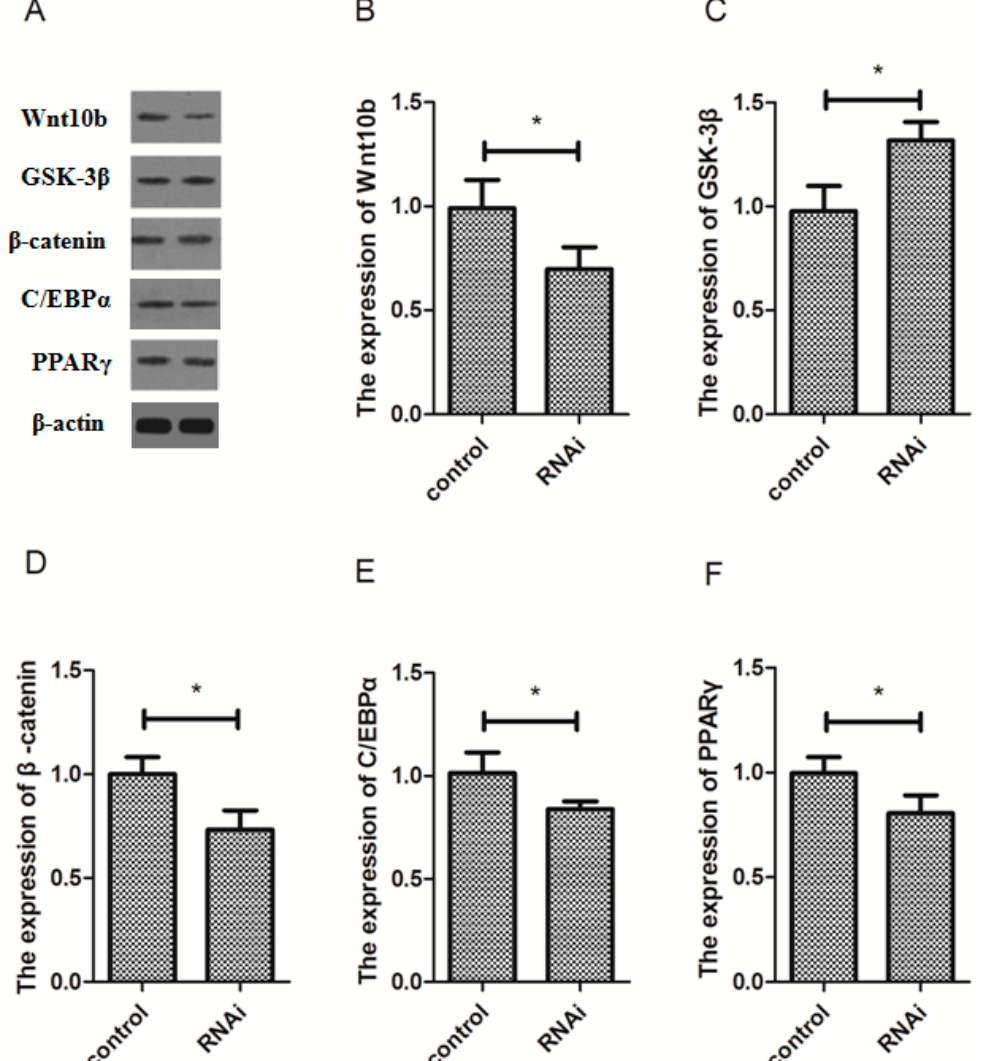
Figure 6. Effect of Wnt10b gene interference on the protein expression of Wnt10b, GSK-3 β , β -catenin, C/EBP α , and PPAR γ in the muscle of zebrafish. ( A ) The protein bands; ( B ) Wnt10b; ( C ) GSK-3 β ; ( D ) β -catenin; ( E ) C/EBP α ; ( F ) PPAR γ . Values are expressed as means ± s.e.m. ( n = 4). Statistically significant differences are denoted by an asterisk (* p < 0.05).